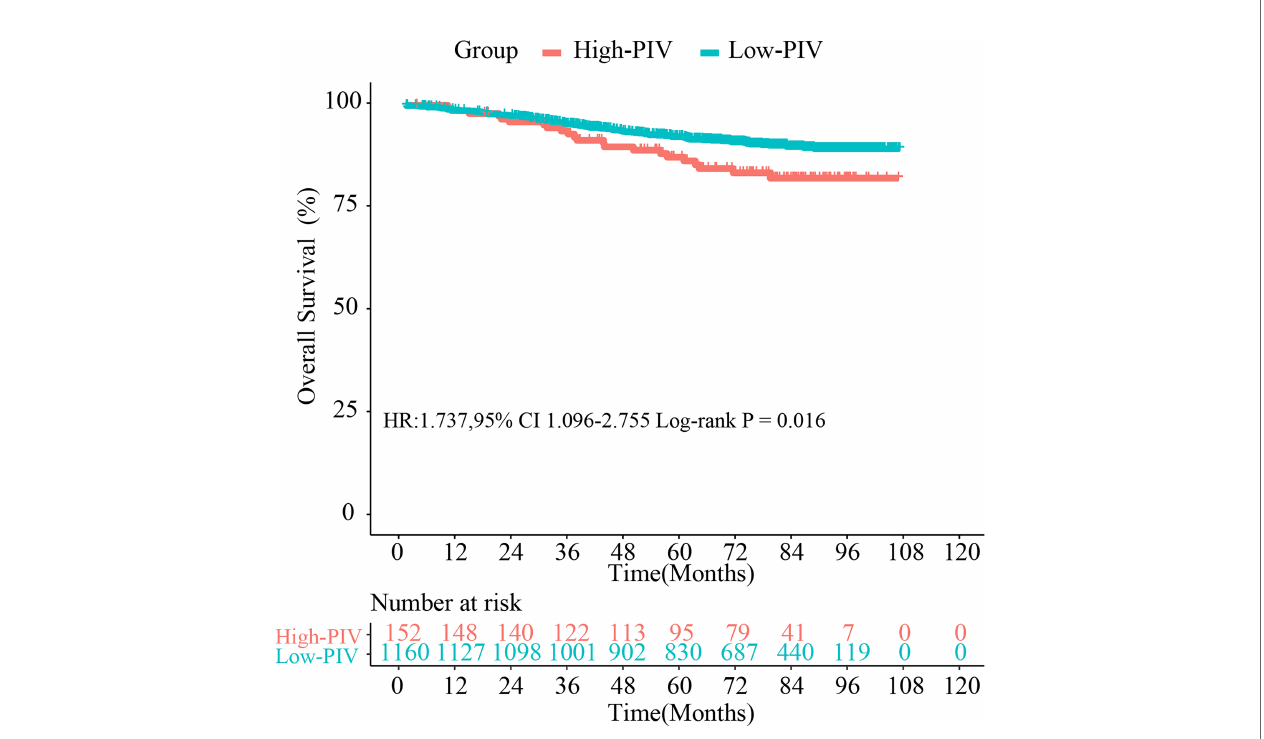
FIGURE 1 | Kaplan – Meier survival curves with breast cancer after surgery between the high-PIV group and low-PIV group in the whole cohort. PIV, pan-immune- in fl ammation value.